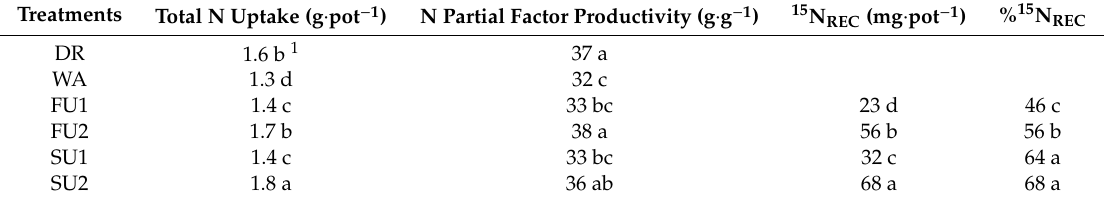
Table 5. E ff ects of urea applied after waterlogging on N uptake, N e ffi ciency, and 15 N REC .